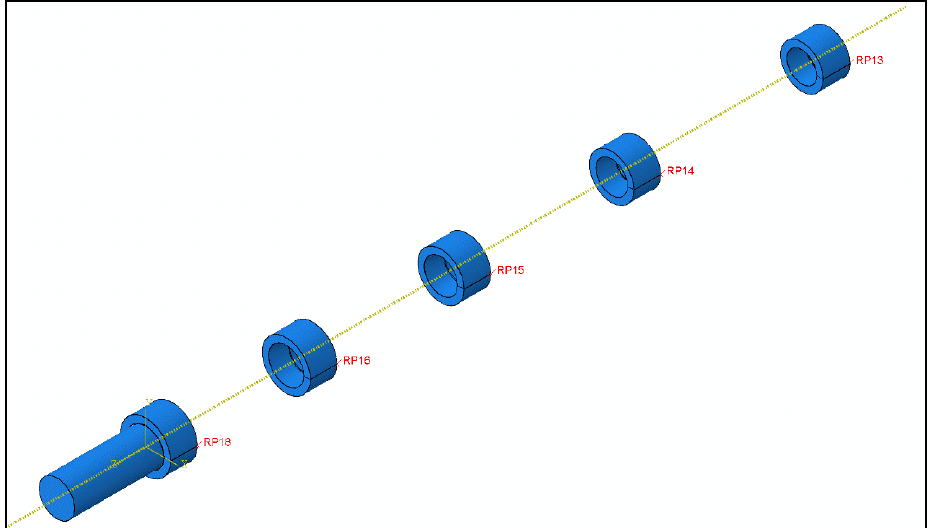
Figure 4. Finite element 3D model of composite material with five-pass drawing.